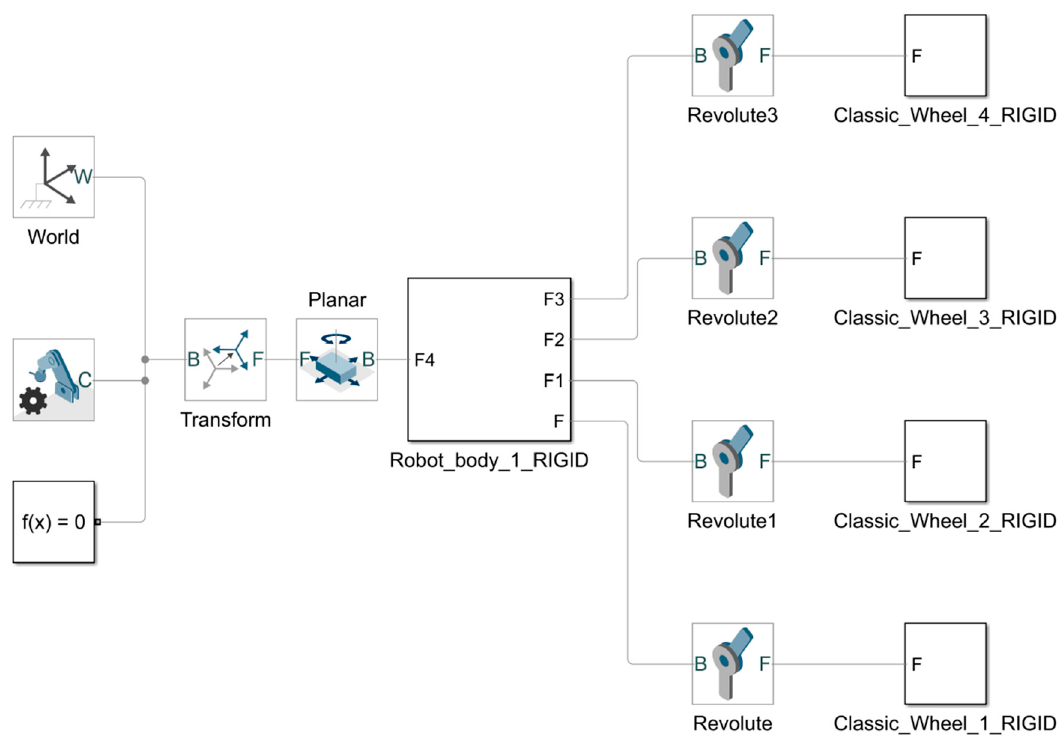
Figure 23. Result of the CAD model import in Simulink Simscape.